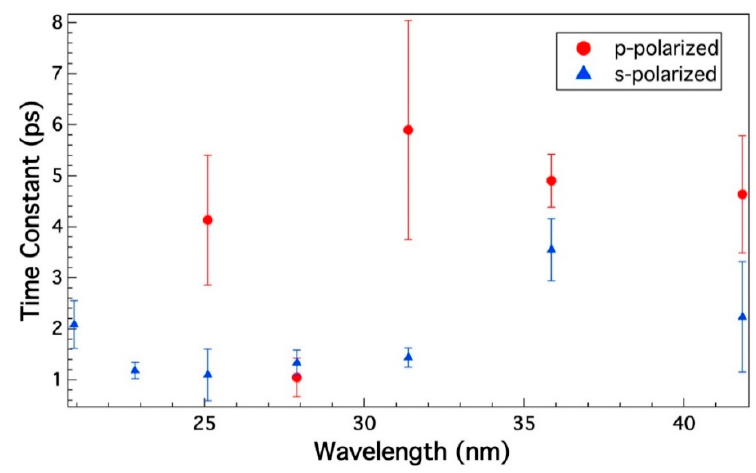
Figure 2. Decay time constants obtained from fitting the experimental data for p-polarized (red circles) and s-polarized (blue triangles) probe as a function of wavelength. The error bars correspond to the error in the fit.